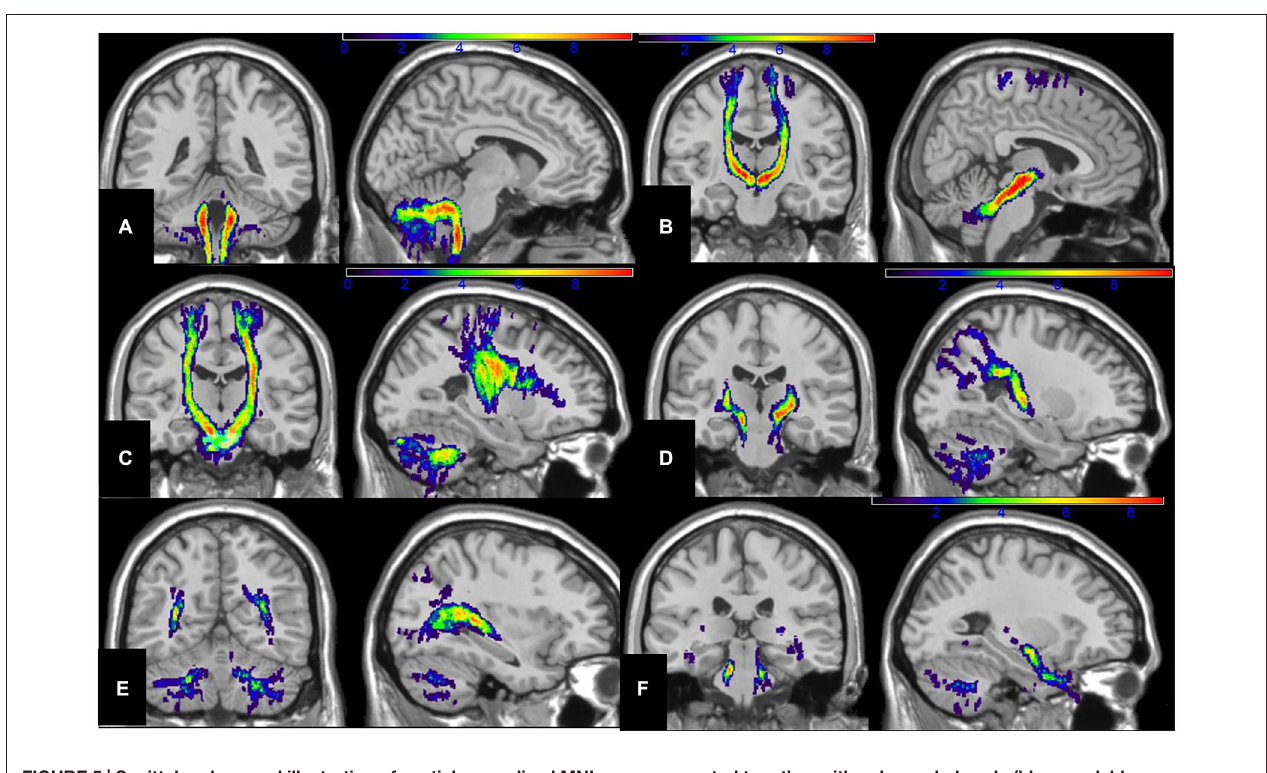
FIGURE 5 | Sagittal and coronal illustration of spatial-normalized MNI summary of the (A) spinocerebellar, (B) dentate-rubro-thalamo-cortical, (C) fronto-ponto-cerebellar, (D) parieto-ponto-cerebellar, (E) occipito-ponto-cerebellar, and (F) temporo-ponto-cerebellar are